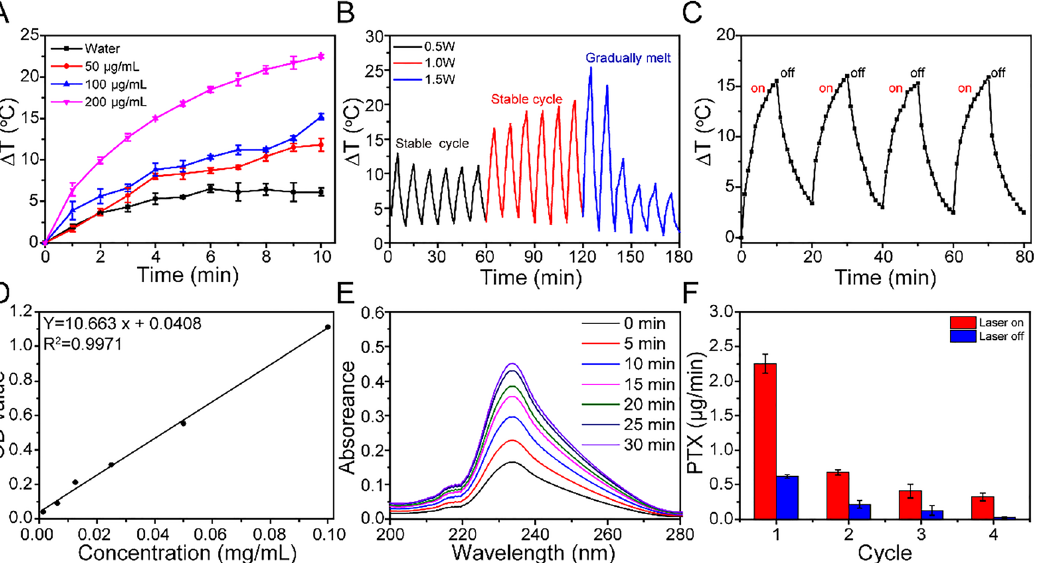
Figure 3: (A) Photothermal heating curves of the OSA/AHA/BPNS with different concentrations of BP nanosheets (0, 50,100 and 200 μ g mL − 1 ) irradiatedwithan NIRlaser (808nm, 1.0 Wcm − 2 ) for10 min. (B)Temperaturechange versustimeunder808 nm laser withpowerof 0.5W cm − 2 during 0 – 60 min, 1 W cm − 2 during 60 – 120 min, and 1.5 W cm − 2 during 120 – 180 min. (C) The photothermal stability test formula of OSA/AHA/ BPNS hydrogel. The power density of the near-infrared light was 1 W cm − 2 . (D) PTX standard curve. (E) Absorbance spectra of released PTX. (F) Release rate of PTX with and without laser